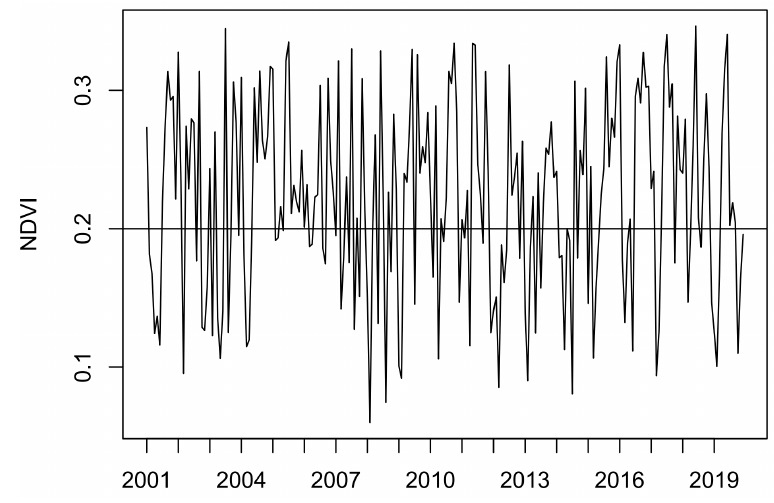
Figure 3. NDVI time series for the period